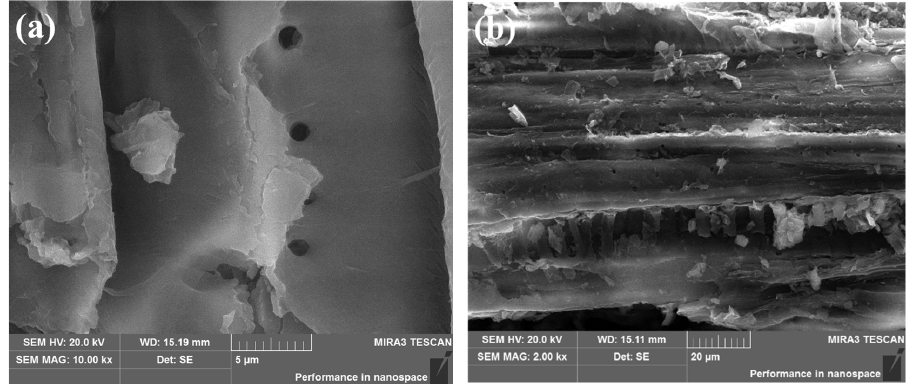
Figure 1. SEM images of BJ160: ( a ) Magnification: 10,000 × ; ( b ) Magnification: 2000 × .